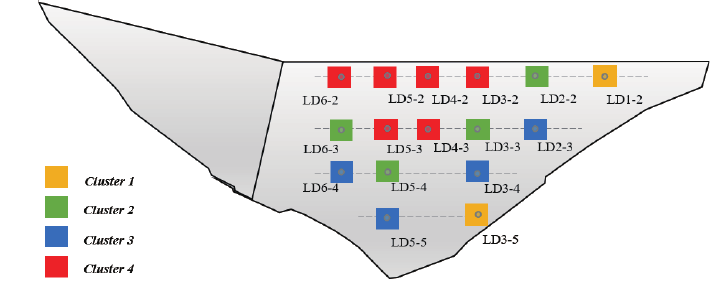
Figure 9. Monitoring points distribution indicated clustering